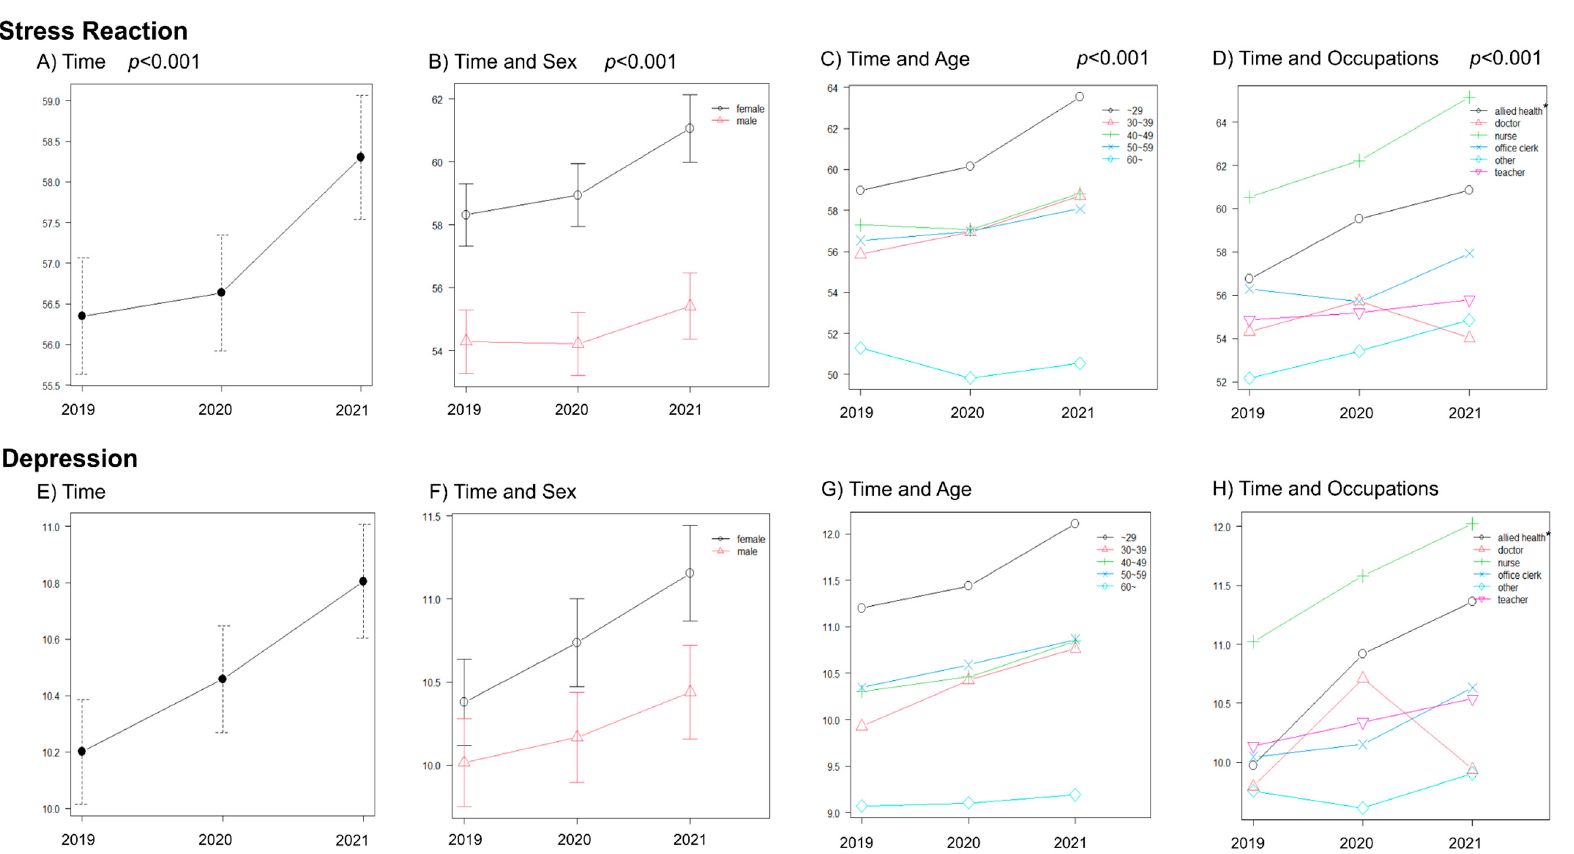
Figure 1. Stress Reaction and Depression among university staff before and during the COVID-19 pandemic. Stress Reaction is one component of the BJSQ and is subdivided into six categories: lack of liveliness, irritability, fatigue, anxiety, depression, and somatic symptoms. Depression scores are a category extracted from six subdivided ones. Stress Reaction and Depression demonstrate ( A – D ) and ( E – H ), respectively. ( A )/( E ) Time, ( B )/( F ) Time and Sex, ( C )/( G ) Time and Age, and ( D )/( H ) Time and Occupation. Line graphs demonstrate changes in Stress Reaction or Depression scores over time, and p -values of Time’s main effects were obtained using repeated measures of two-way ANOVA. Error bars indicate 95% CI. * allied health = allied health professional ANOVA, analysis of variance; BJSQ, brief job stress questionnaire; CI, confidence interval; COVID-19, coronavirus disease-2019.